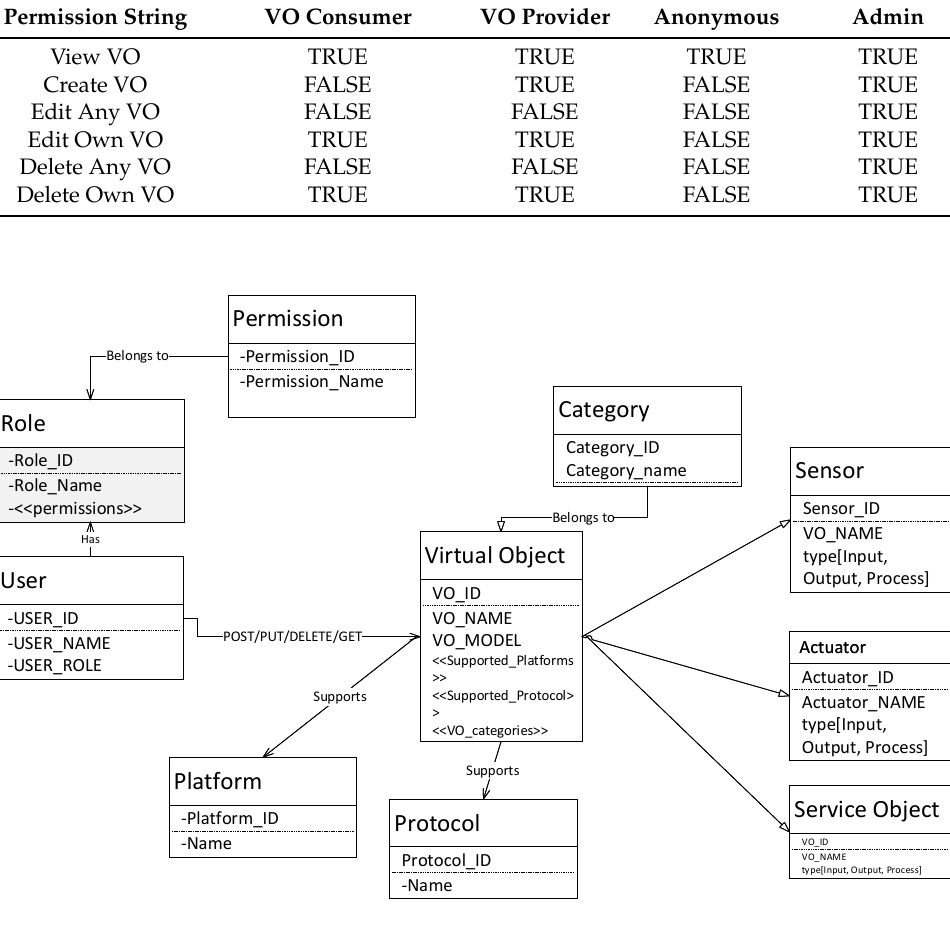
Figure 8. Class diagram of the application